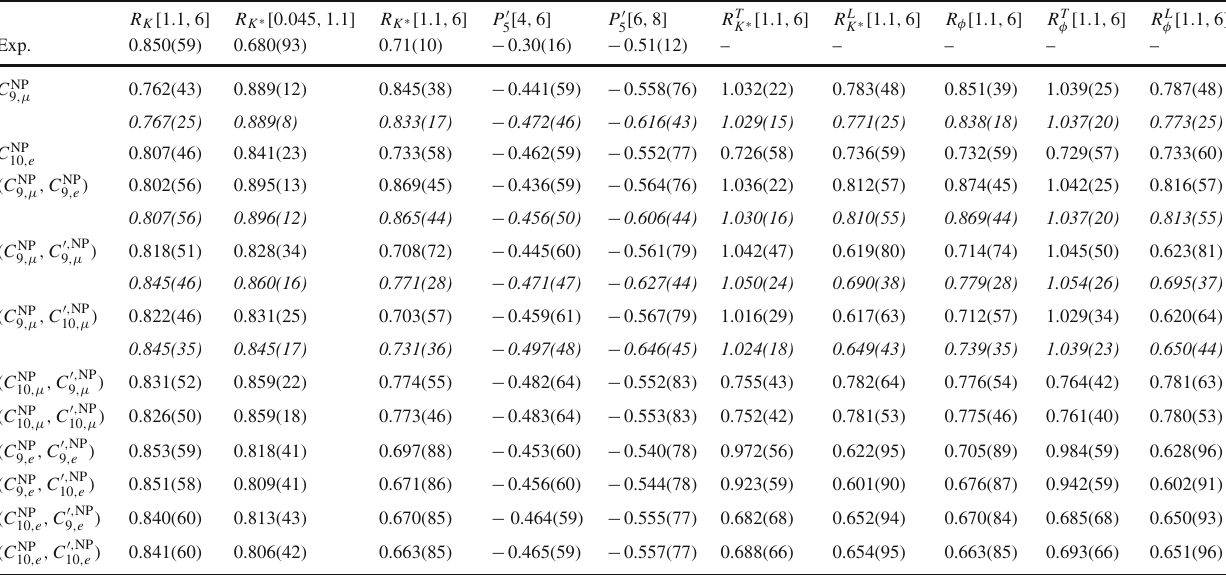
ues highlight the PMD results when experimental data can be well described within the approach. The PDD results are presented for all cases. For the definition of the two approaches, see Sect. 2.1